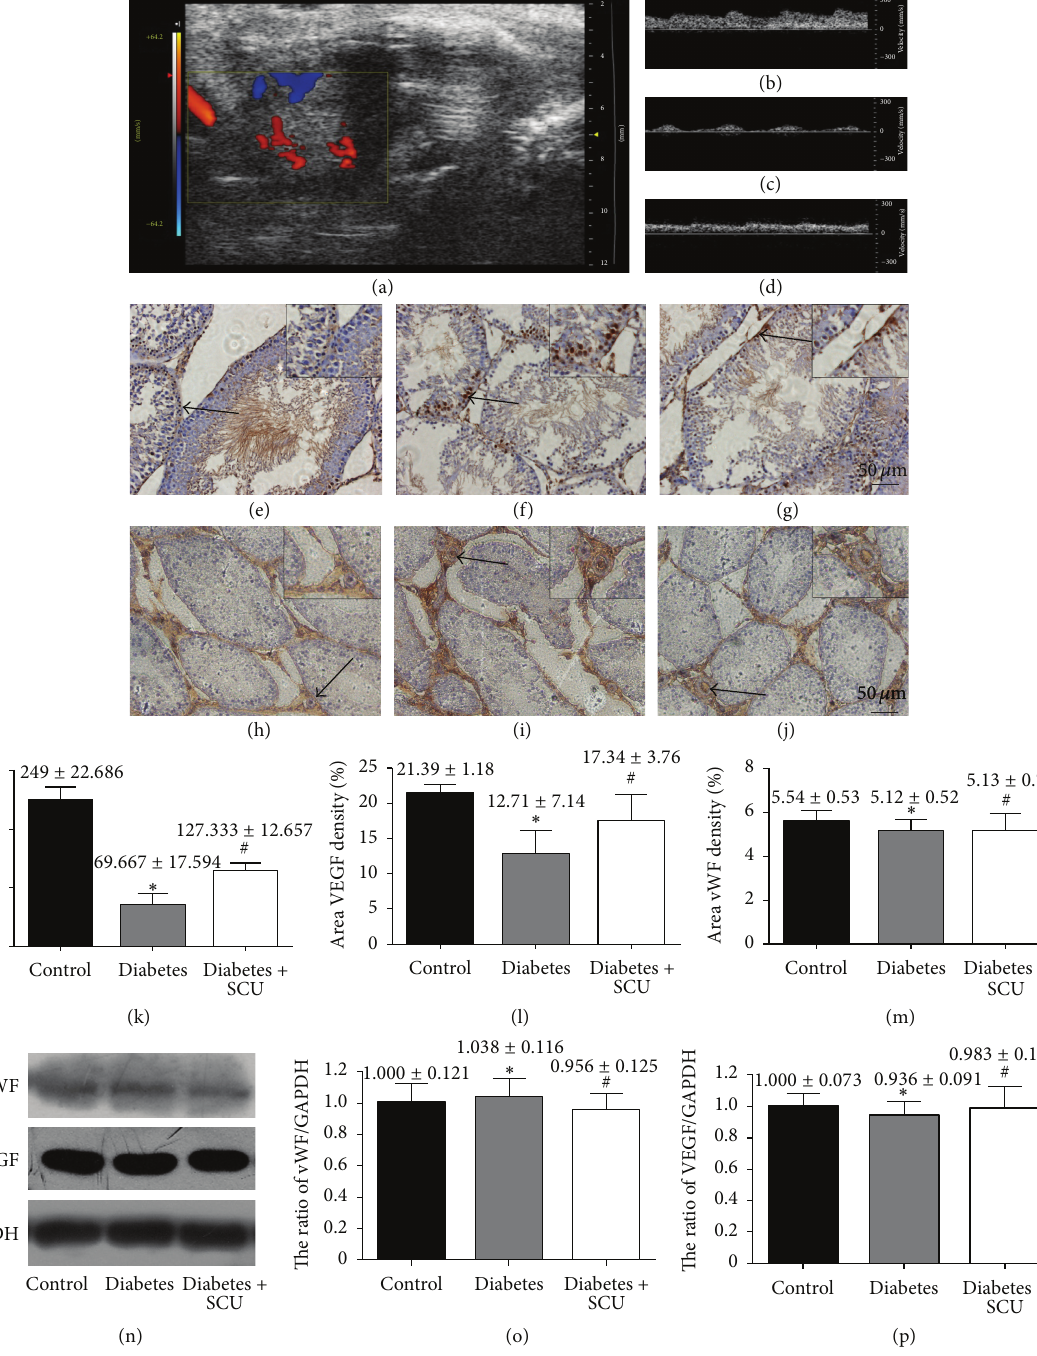
Figure 5: FSCU improve diabetes-induced microcirculatory changes. (a)–(d) Colour Doppler sonography analysis was performed in experimental animals. (a) Color Doppler ultrasound image from a diabetes + SCU rat testis showing localization of testicular blood vessel. (b)–(d) Spectral analysis of testicular blood flow rate in control, diabetes, and diabetes + SCU groups, respectively. (k) Quantitative evaluation of velocity. Data presented in (e) are means ± SEM ( 𝑛 = 8 per group; ∗ significantly different from control group ( 𝑃 ≤ 0.05 ), # significantly different from diabetes group ( 𝑃 ≤ 0.05 )). (e)–(j) The images of immunostaining of VEGF and vWF (arrows are used to indicate VEGF or vWF positive cells). (e) and (h) for control group, (f) and (i) for diabetes group, and (g) and (j) for diabetes + SCU group. DAB was used as background staining. VEGF or vWF density (% of area) was determined using Image-Pro Plus to calculate the total area of positive cells. Data in (l) and (m) are presented as means ± SEM, 3 fields per section and 5 sections from each testis, 𝑛 = 8 rats for each group. (n) representative western blots show expression of vWF and VEGF. Bar graphs in (o) and (p) present quantitative difference in expression of vWF and VEGF. Data in (l) and (o) are presented as means ± SEM. ∗ Significantly different from control group ( 𝑃 ≤ 0.05 ), # Significantly different from diabetes group ( 𝑃 ≤ 0.05 ). Data in (m) and (p) are presented as means ± SEM, 𝑛 = 8 rats for each group. ∗ No significantly different from control group ( 𝑃 ≥ 0.05 ), # No significantly different from diabetes group ( 𝑃 ≤ 0.05